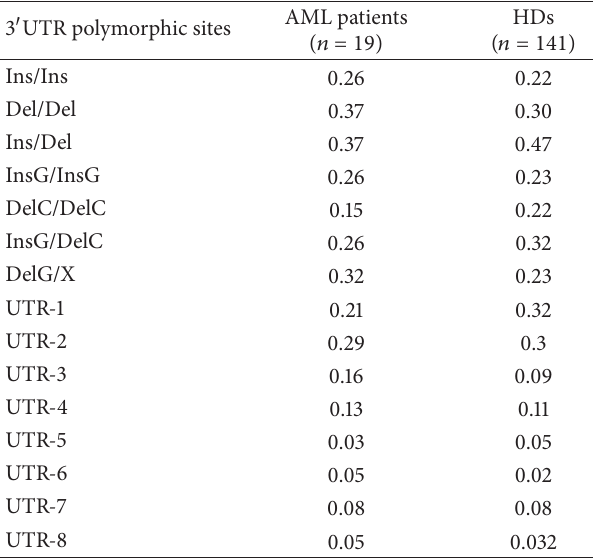
Table 3: Frequency of 3 󸀠 UTR haplotypes and genotypes. 3 󸀠 UTR polymorphic